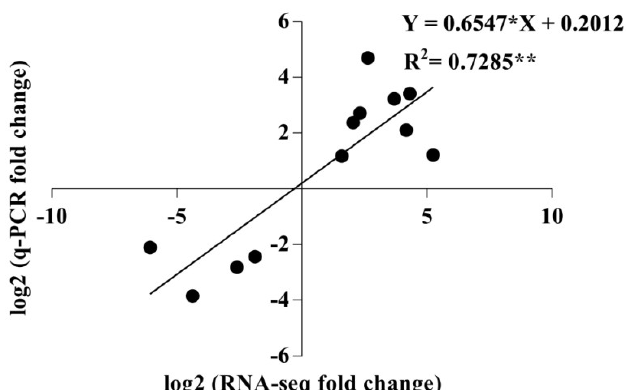
Figure 7. Comparison of expression levels measured by RNA-Seq and qRT-PCR for 12 selected differentially expressed genes for TG2 vs. D2 (nine DEGs) and TD2 vs. D2 (three DEGs).